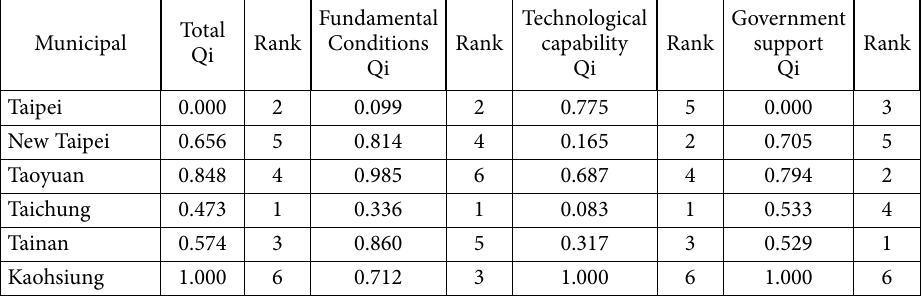
Table 6. Innovation and technology capabilities for the six metropolitan areas-8 Govt. sector experts Municipal